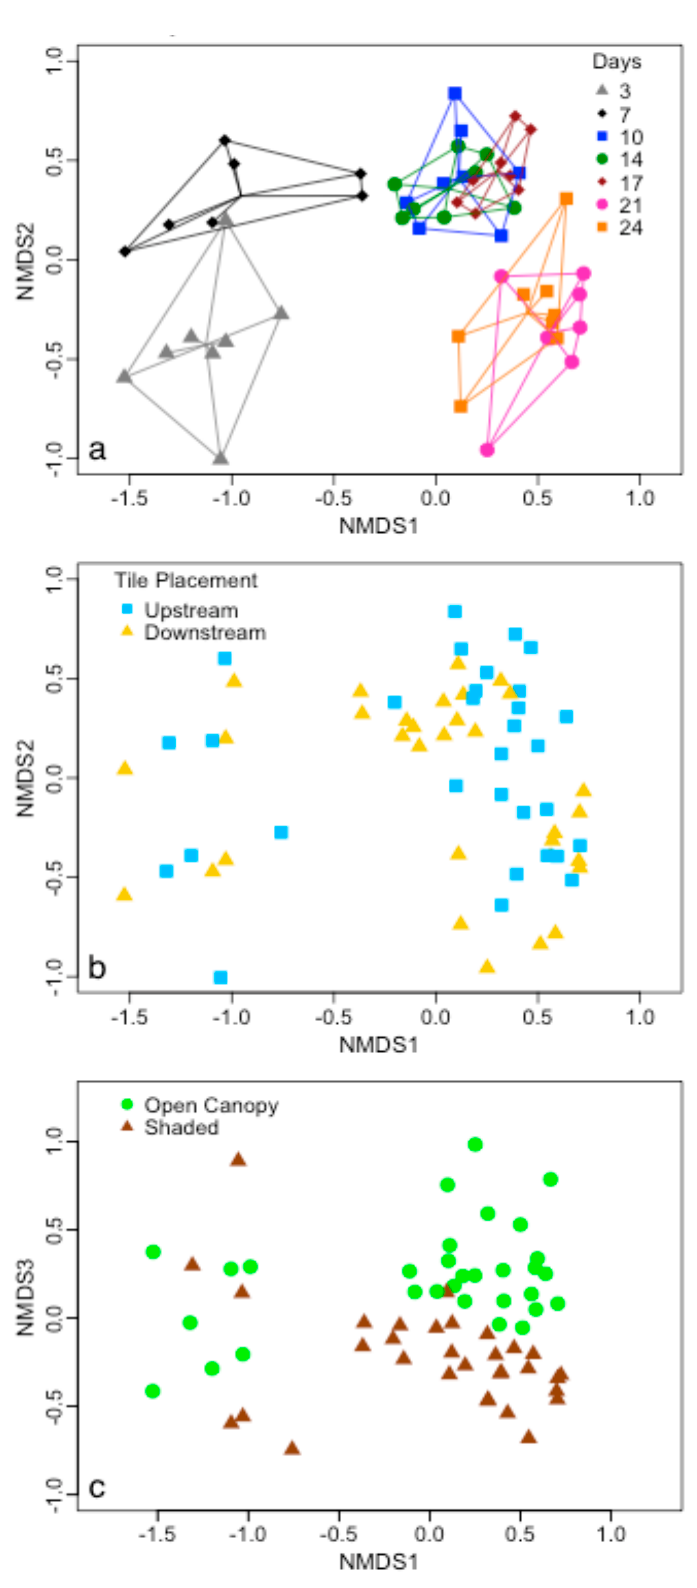
Figure 4. Bacterial community structure of epilithic biofilms in Farmersville, OH, USA is depicted using NMDS ordination (3-D, R 2 = 0.98, stress = 0.13) and overlaid with ( a ) days of growth, ( b ) tile placement, and ( c ) canopy with convex hulls and spider lines that connect at the group midpoint. Both days and canopy were significant determined by PERMANOVA. Note that canopy ordinates along the NMDS Axis 3.